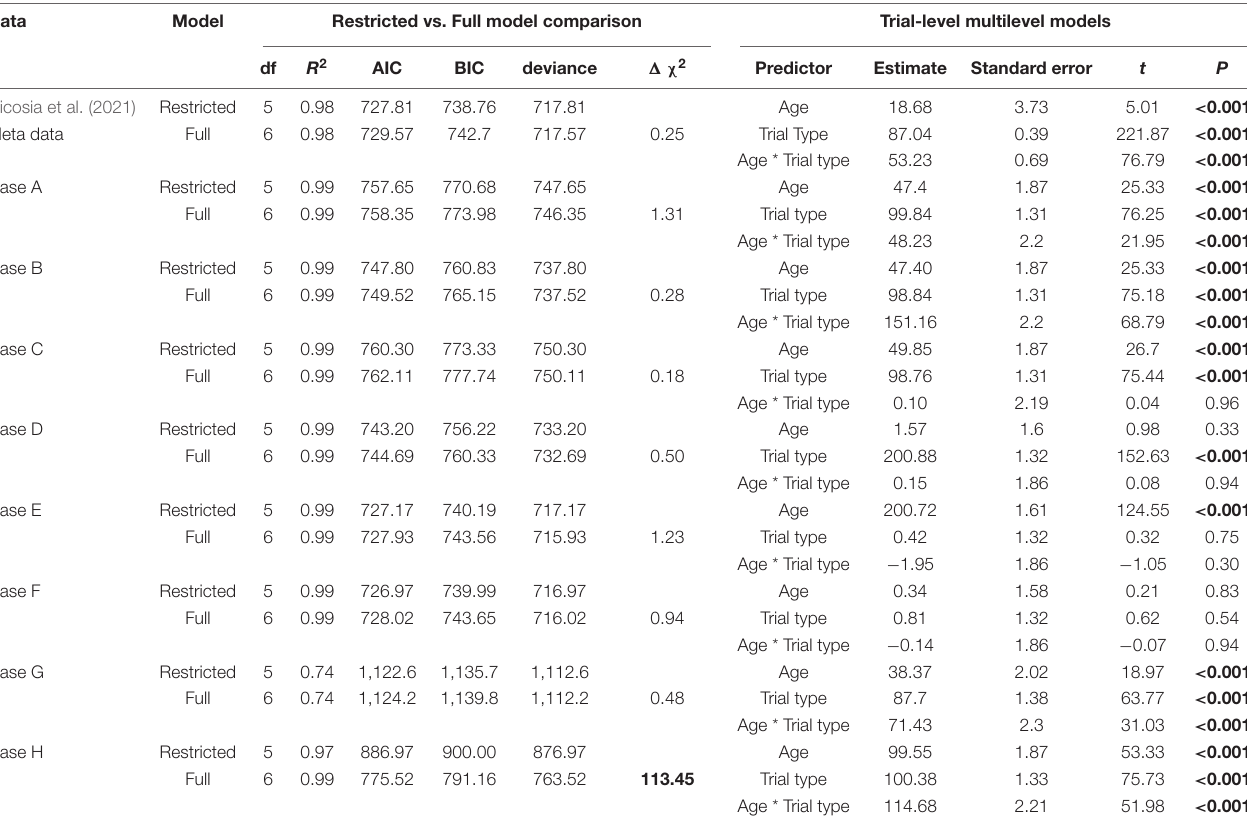
TABLE 2 | Model comparison and trial-level multilevel model